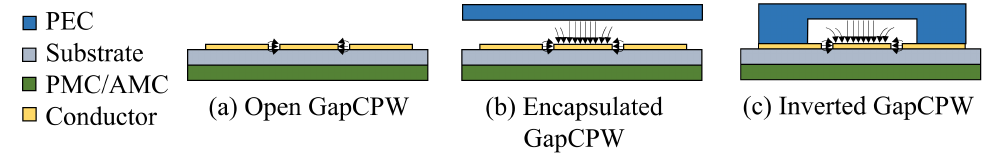
Figure 2. Proposed versions of the Gap Coplanar Waveguide. ( a ) GapCPW. ( b ) Encapsulated GapCPW. ( c ) Inverted